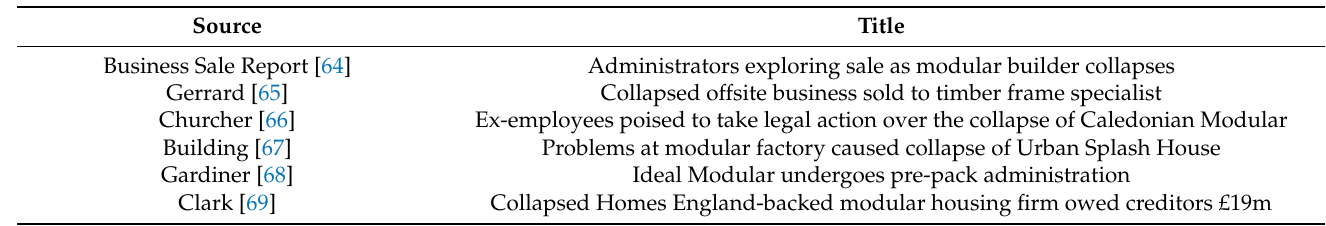
Figure 2. Company Insolvency Statistics—October to December 2022 (from The Insolvency Ser- vice [63]). Table 1. News coverage mentioning MMC businesses.